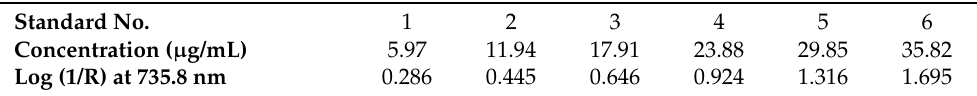
Table 1. Absorbance of gallic acid monohydrate at different concentrations. Standard No.